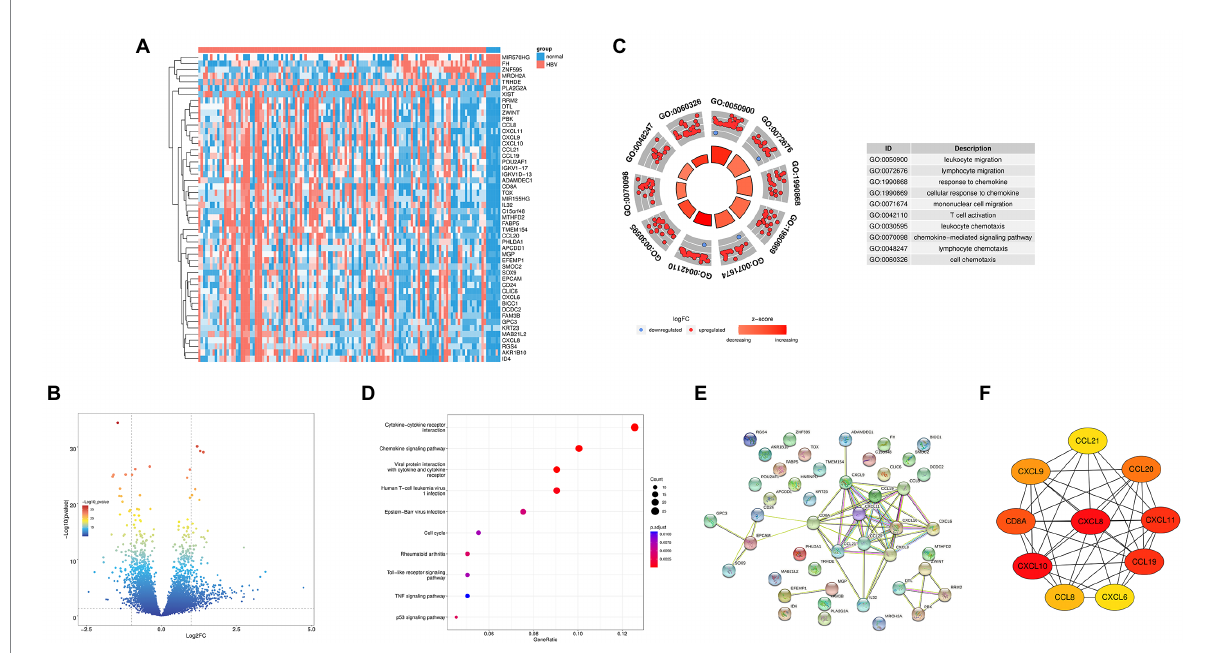
FIGURE 1 Identification of the Hub genes in HBV infection. (A) Heat map of top50 differential genes, with blue representing downregulated genes and pink representing upregulated genes; (B) Volcanic plot of differentially expressed genes. (C) GO analysis diagrams of differential gene; (D) KEGG analysis diagrams of differential genes; (E) PPI network for top50 differential genes. (F) Interaction network for hub